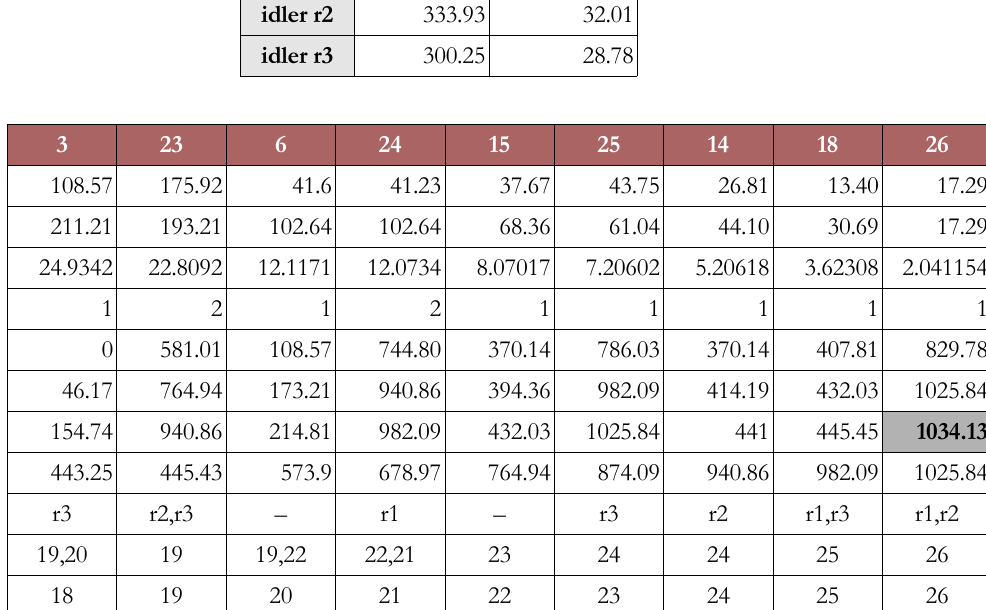
Table 16. ACTIM Scheduling, Rmax = 3, n(r) = 3 (Scenario